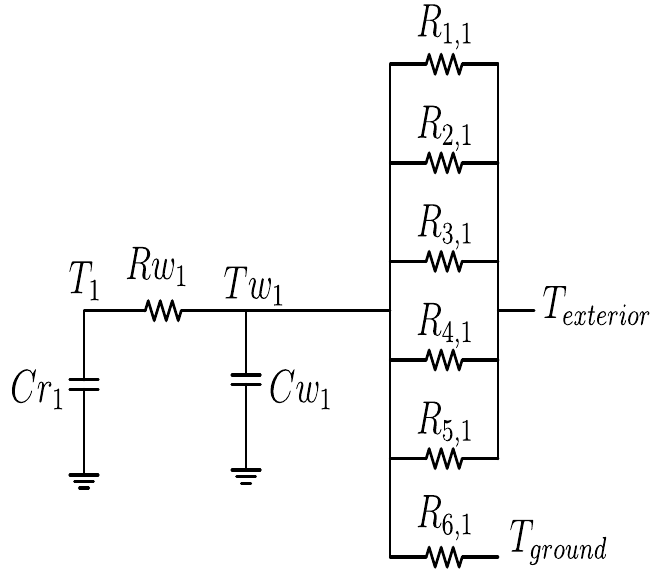
Figure 2. Circuit for a single thermal